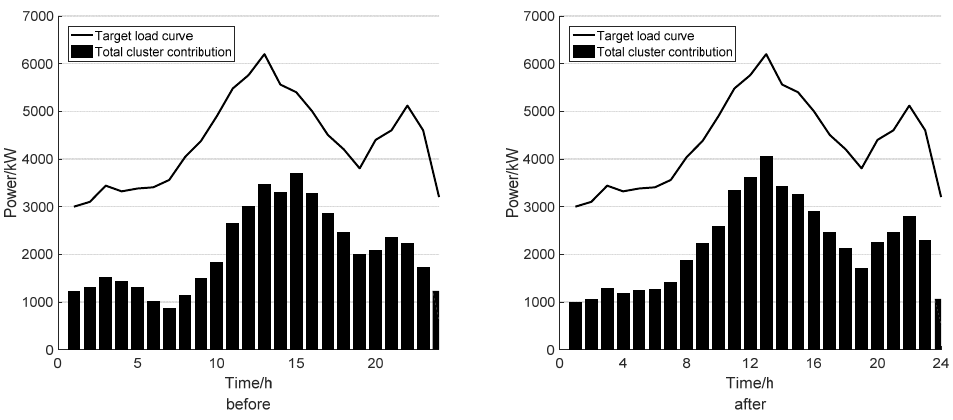
Figure 5. Target load curve.